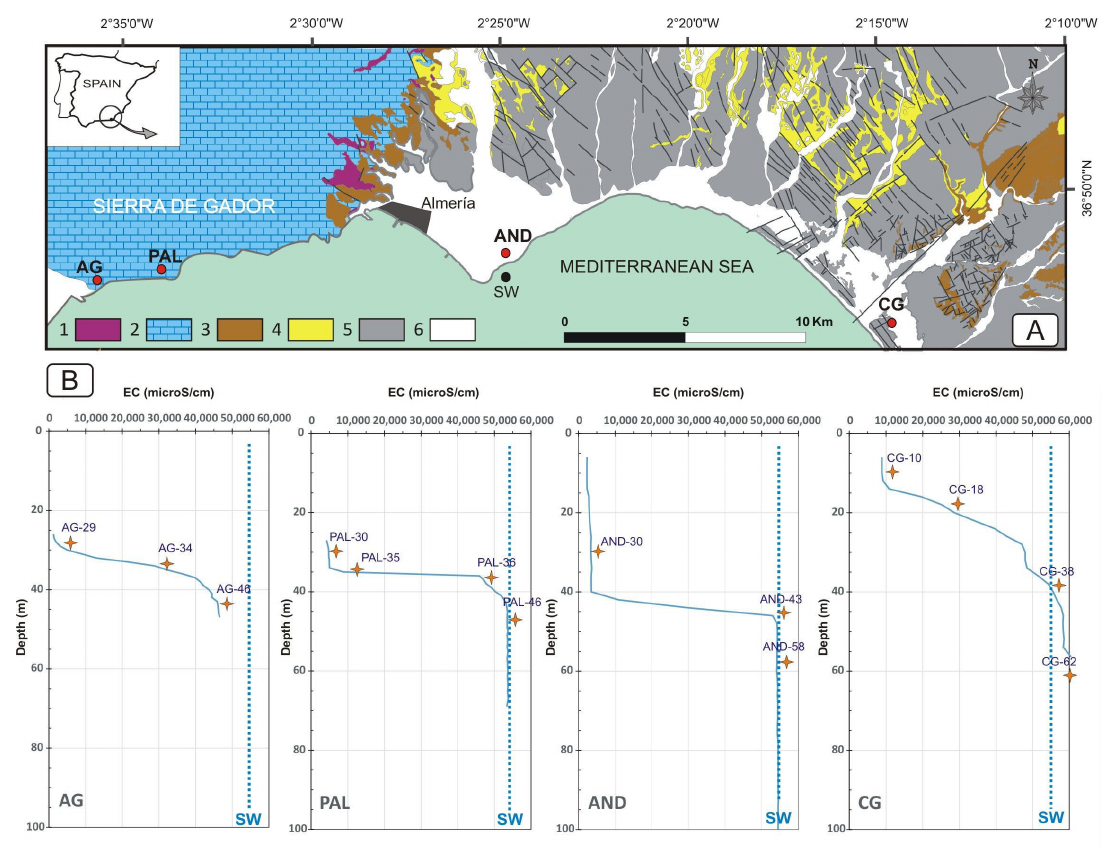
Figure 1. ( A ): Location of study sites (AG—Aguadulce, PAL—Palmer, AND—Andarax delta, CG— Cabo de Gata littoral plain), SW —seawater and geological context (1—metapelite, 2—carbonate, 3— coarse neogene sediments, 4— fine neogene sediments, 5—quaternary deposits, 6—holocene allu- vial deposits). ( B ): Electrical conductivity (EC) profiles of groundwater (dotted line —seawater EC; star—sampling point depth).